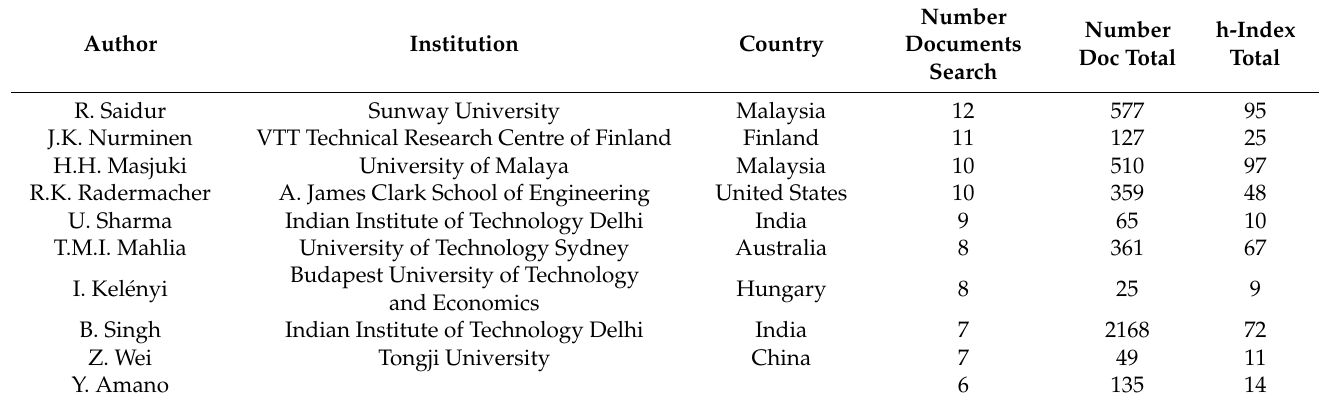
Table 3. Authors with more publications in the field of study.